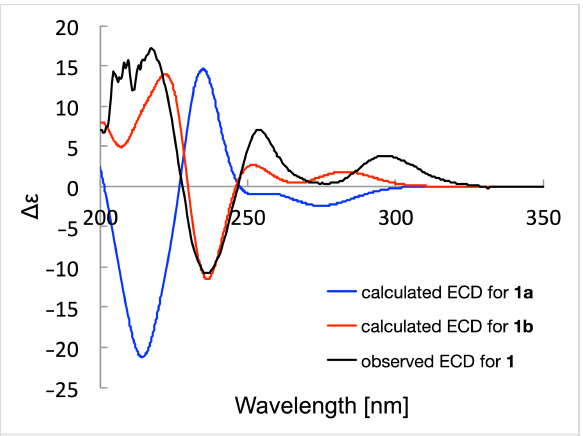
Figure 5: The experimental and calculated ECD spectra in MeCN.